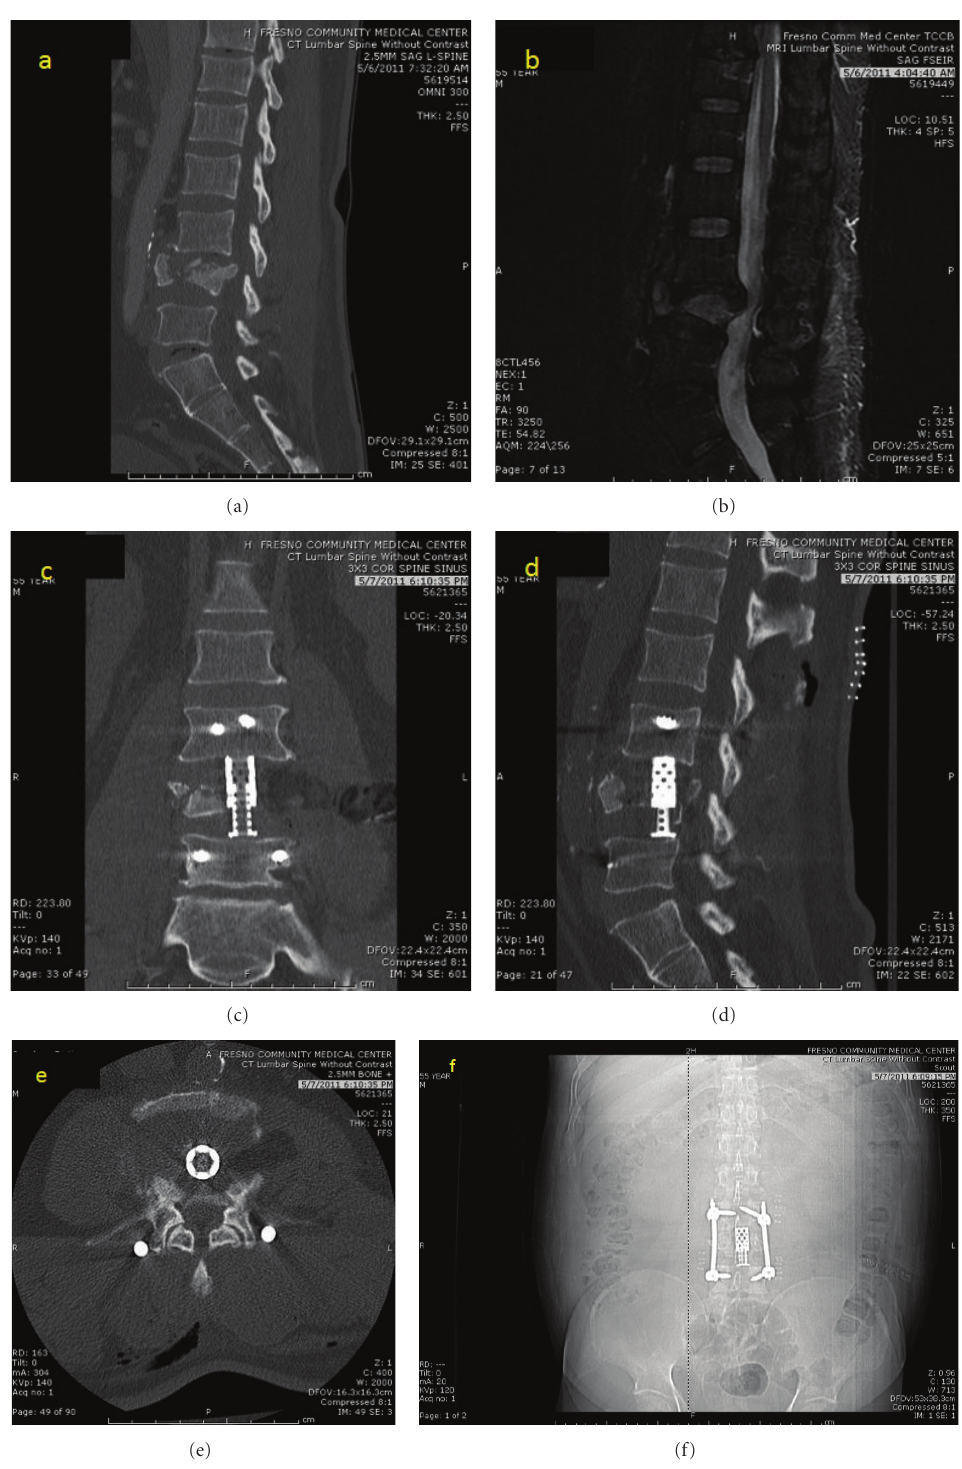
Figure 3: 21-year-old who su ff ered a roll-over MVC and L4 burst fracture, and who underwent MIS lateral corpectomy: significant preoperative and postoperative images